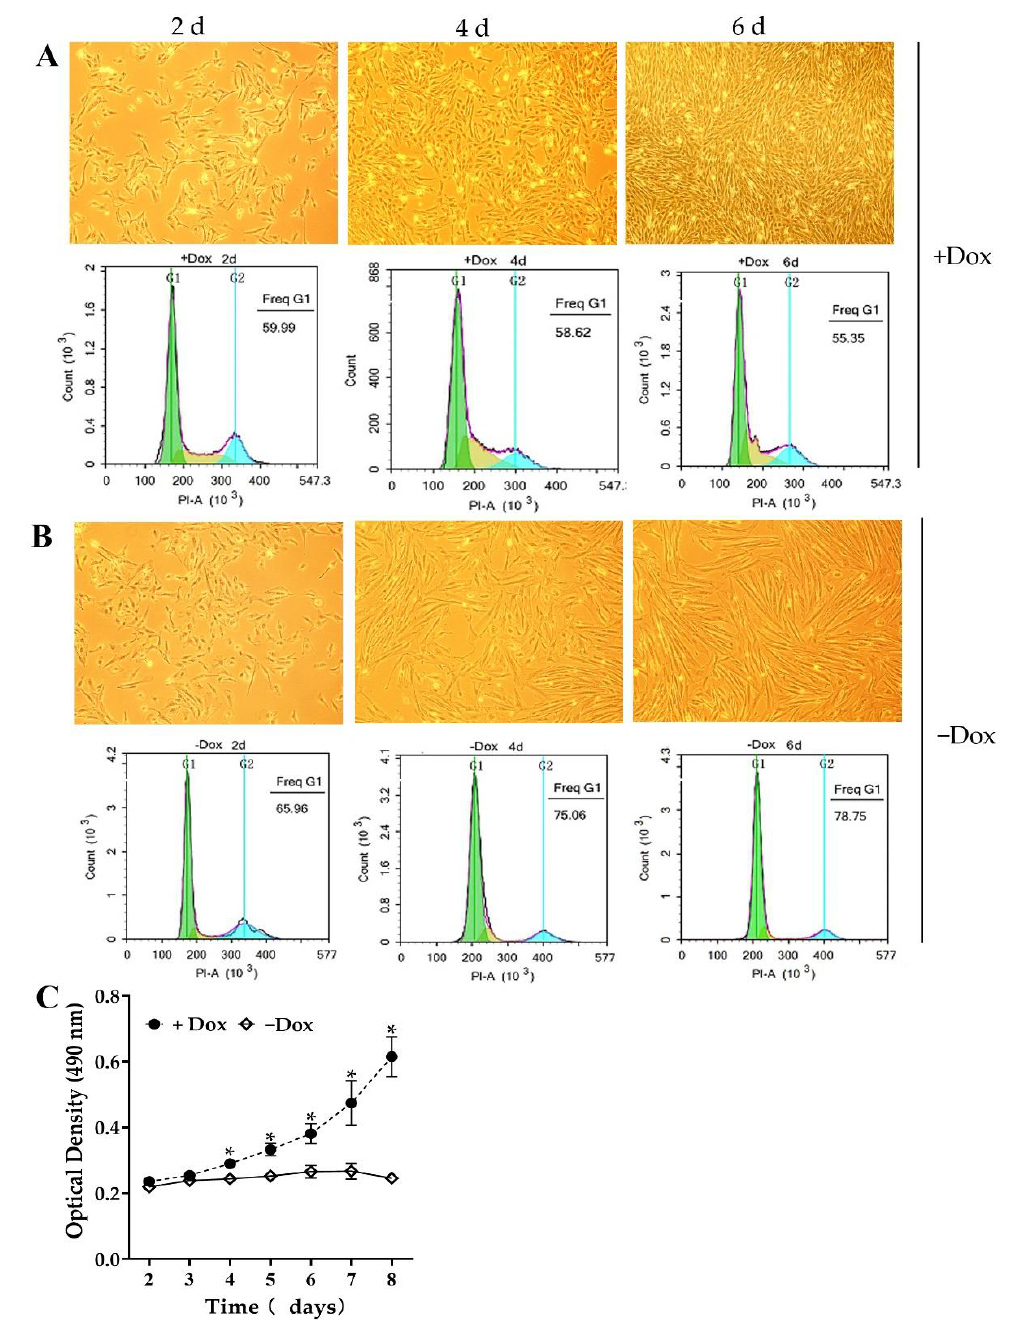
Figure 4. Proliferation of CIPGCs induced by Dox. ( A ) The morphology and cell cycle analysis of CIPGCs with Dox induction for culture. ( B ) The morphology and cycle analysis of CIPGCs without Dox induction for culture, cell cycle analysis showed that more cells were in S/M (Synthesis/Mitotic) phase during induction by Dox; at the withdrawal of Dox, percentage of cells in S/M phases